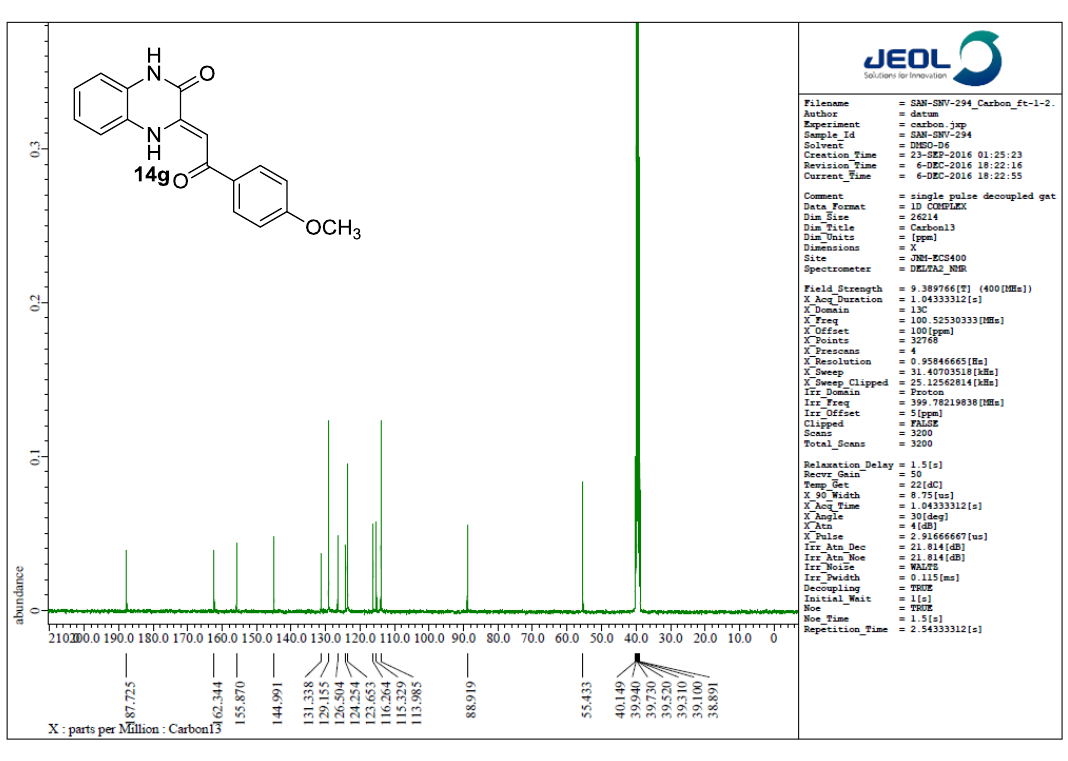
Figure 42 . 13 C NMR Spectra of Compound 14g